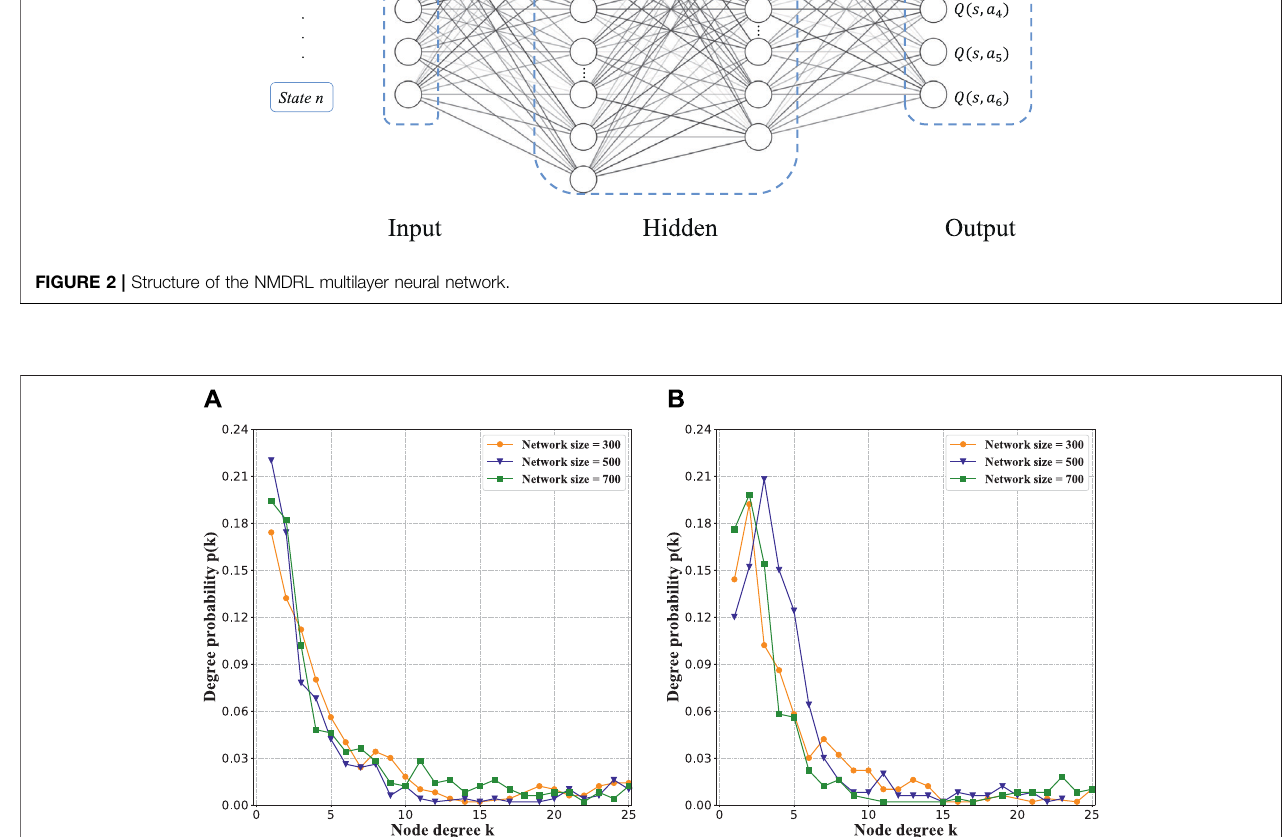
FIGURE 3 | (A,B) are the degree distributions of the networks generated by NMDRL